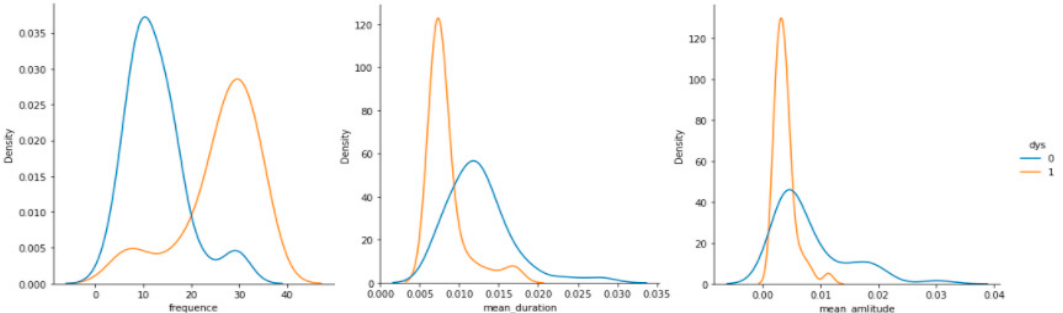
Figure A9. Distribution of the DGI for the painting 5 dataset.